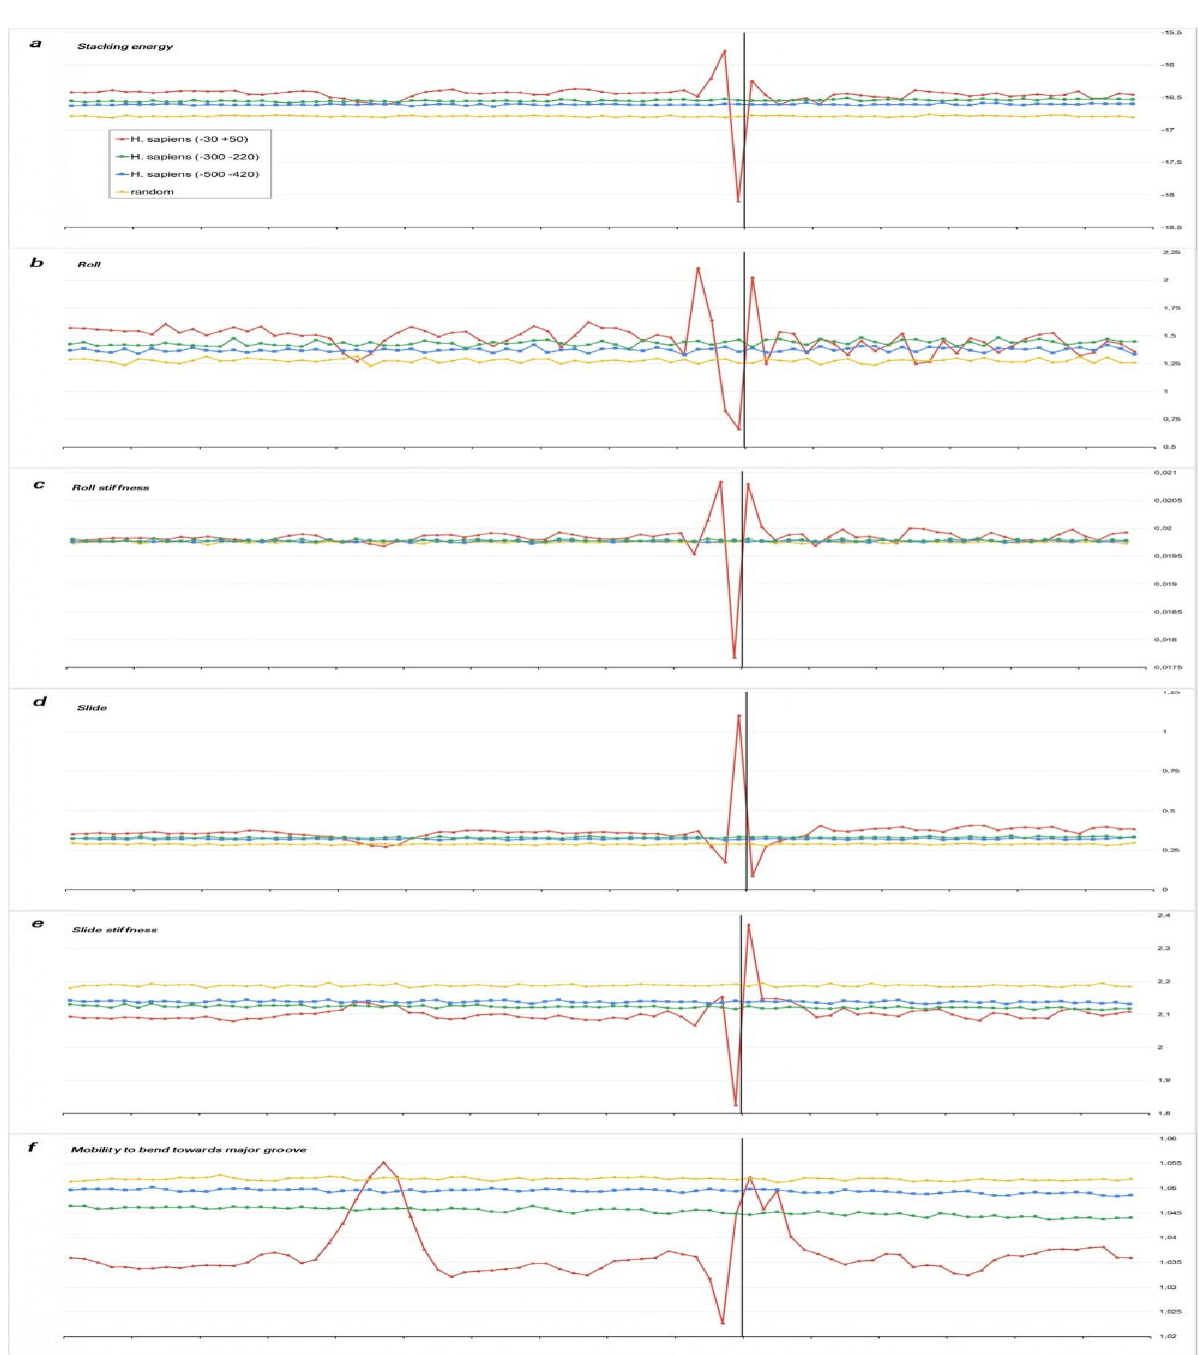
along with the profiles of the H. sapiens core promoters.